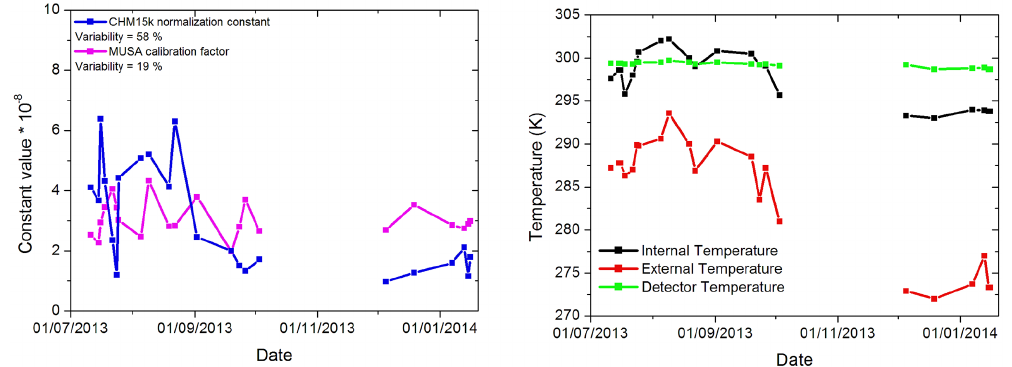
Figure 2. Left panel: the CHM15k calibration constant (blue squares) has been plotted as a function of the case number along with the lidar calibration constant (magenta squares) used for the molecular retrieval of the 1064nm lidar backscatter coefficient, i.e. the constant used to normalize the lidar 1064nm profile over the molecular profile; right panel: temperature of the CHM15k detector (green squares), the external (red squares) and the internal temperatures (dark squares) recorded by the instrument sensors for the cases with simultaneous measurements with MUSA. The period where no data are plotted corresponds to the an EARLINET intercomparison campaign in which MUSA was involved and moved for an intercomparison campaign in southern Italy (Wandinger et al.,